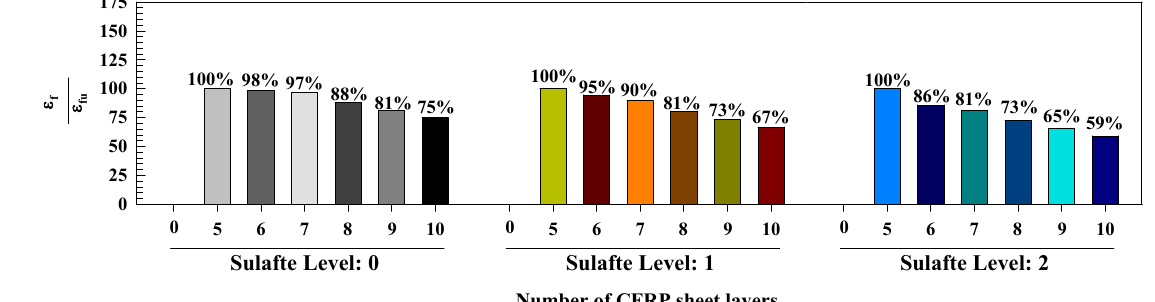
Figure 15. CFRP strain percentages .